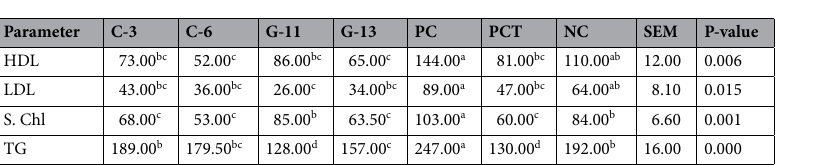
Table 3. Effect of probiotic strains supplementation on Lipid Profile of diabetic mice. Values are the mean ± standard error of the mean of two replicates. Within each variable, values with the same superscript letter ( a, b, c, d, ab, bc ) are not significantly different according to Duncan’s multiple range test (P > 0.05).